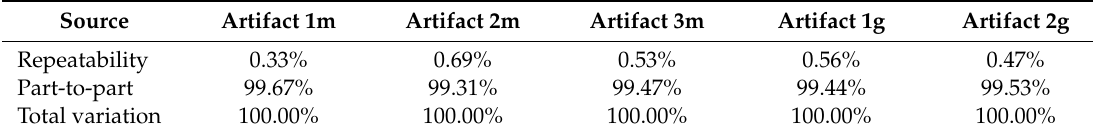
Table 7. The percentage contribution of variance components/artifacts.